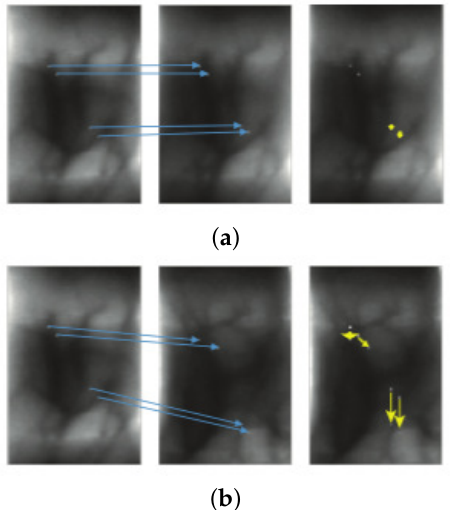
Figure 3. Comparison of displacements for genuine and imposter matching, image from [45]. ( a ) genuine matching: the displacements tend to be similar in length and direction for matched pixels; ( b ) imposter matching: the displacements vary in distance and in various directions for matched